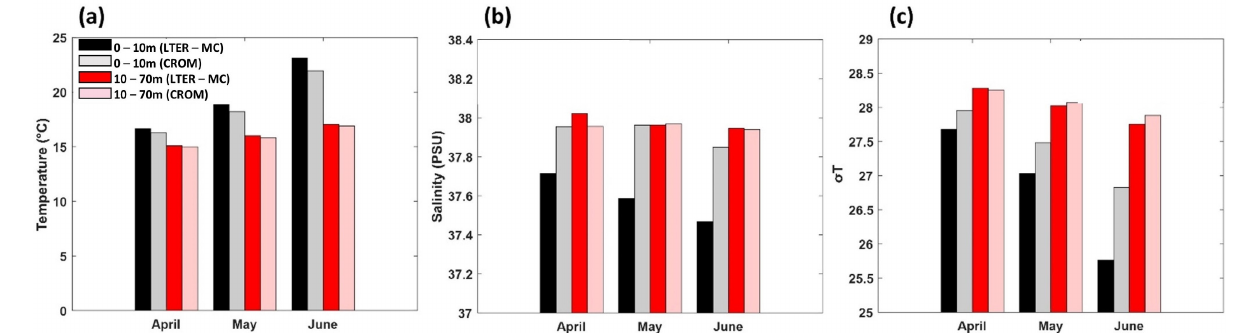
Figure 11. Monthly mean of T ( a ), S ( b ) and ρ ( c ) observed at the LTER ‐ MC sampling station and simulated by CROM in the area of Figure 8 for April, May and June 2016.